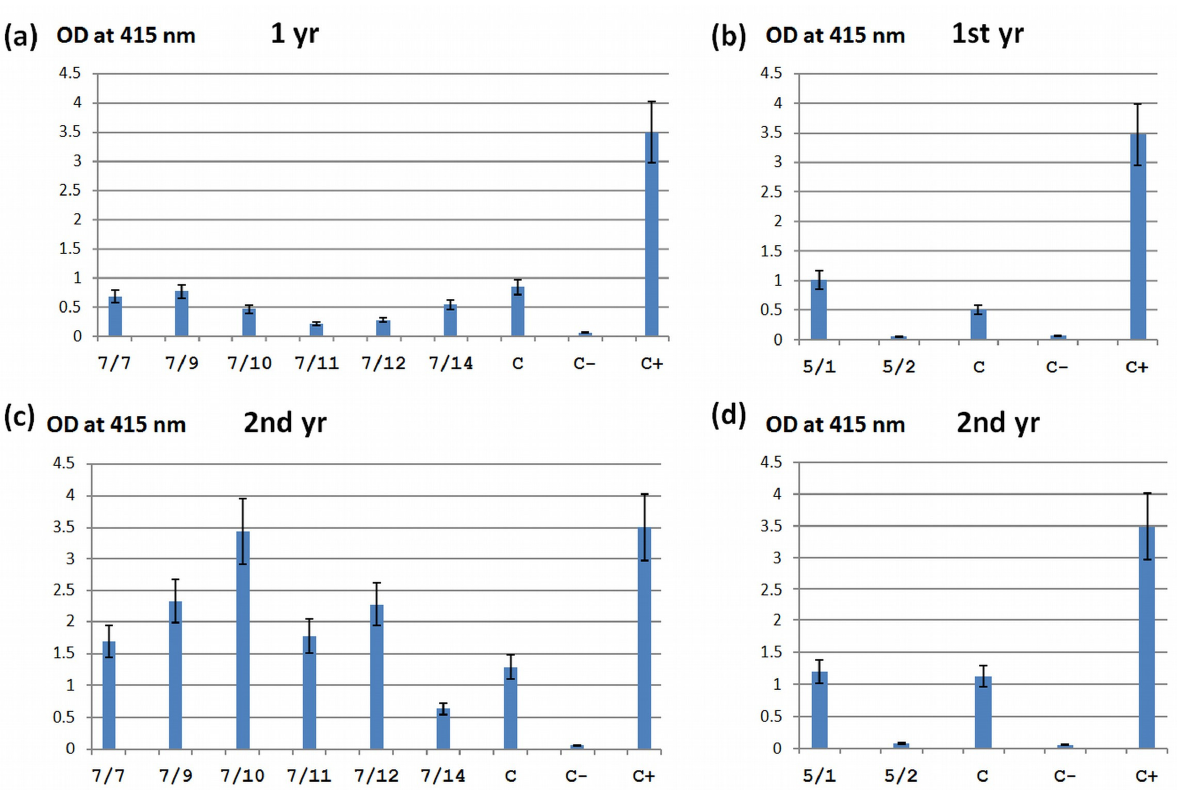
Figure 6. DAS-ELISA analysis of infected transgenic rootstock 146-2 plants after 1 ( a , b ) and 2 ( c , d ) years from inoculation of PPV. ( a , c ) Detection of the virus in transgenic lines (7/7–7/14) containing the eIFiso4G gene silencing construct. ( b , d ) Detection of the virus in transgenic lines (5/1 and 5/2) containing the eIFiso4E gene silencing construct. The rootstock plants 146-2 were not infected with PPV (C − ). The rootstock plants 146-2 (wild type) infected with PPV (C). Positive control on PPV from the BIOREBA kit (C+).